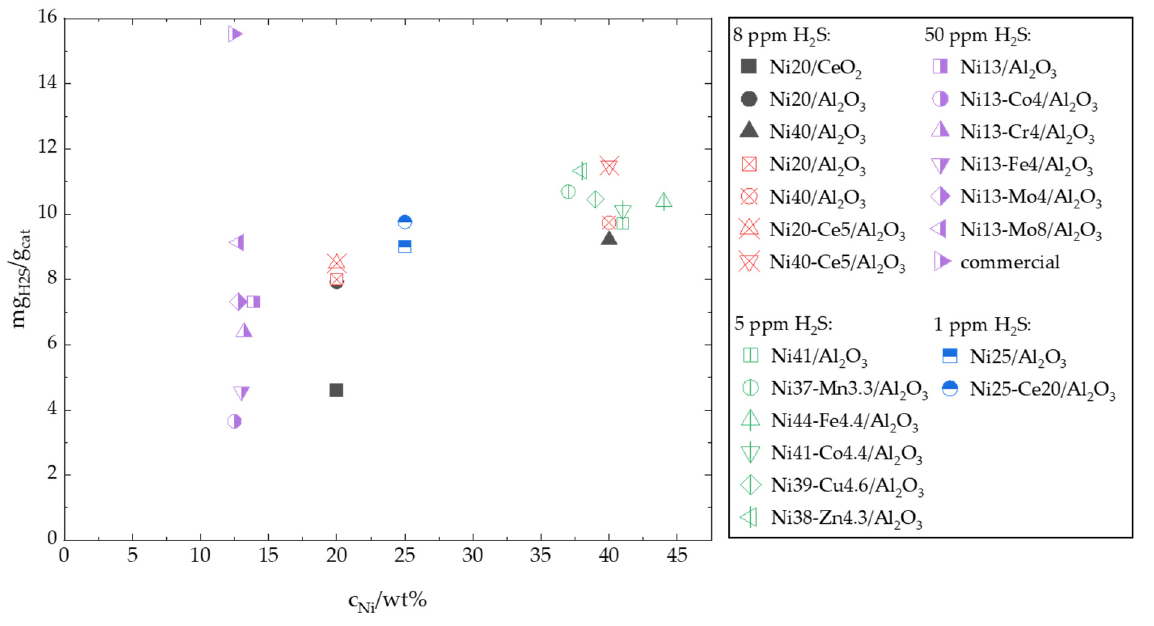
Figure 9. Correlation of total fed H 2 S amount and metal content until complete deactivation (beginning of phase 3) for the catalysts from studies discussed in Section 7. Calculations are given in Appendix B.